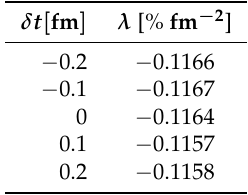
Table 9. Calculated proportionality constant λ in the linear fit λδ (cid:104) r 2 n (cid:105) for different skin thickness deviations δ t from the reference model ( t =